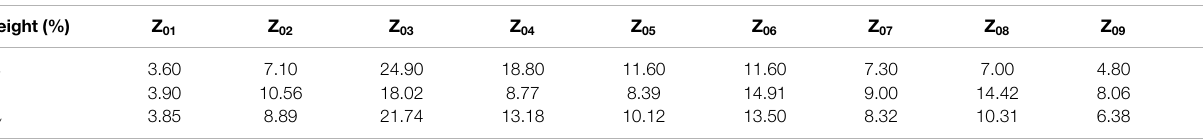
TABLE 3 | Constant weight of the principal component of